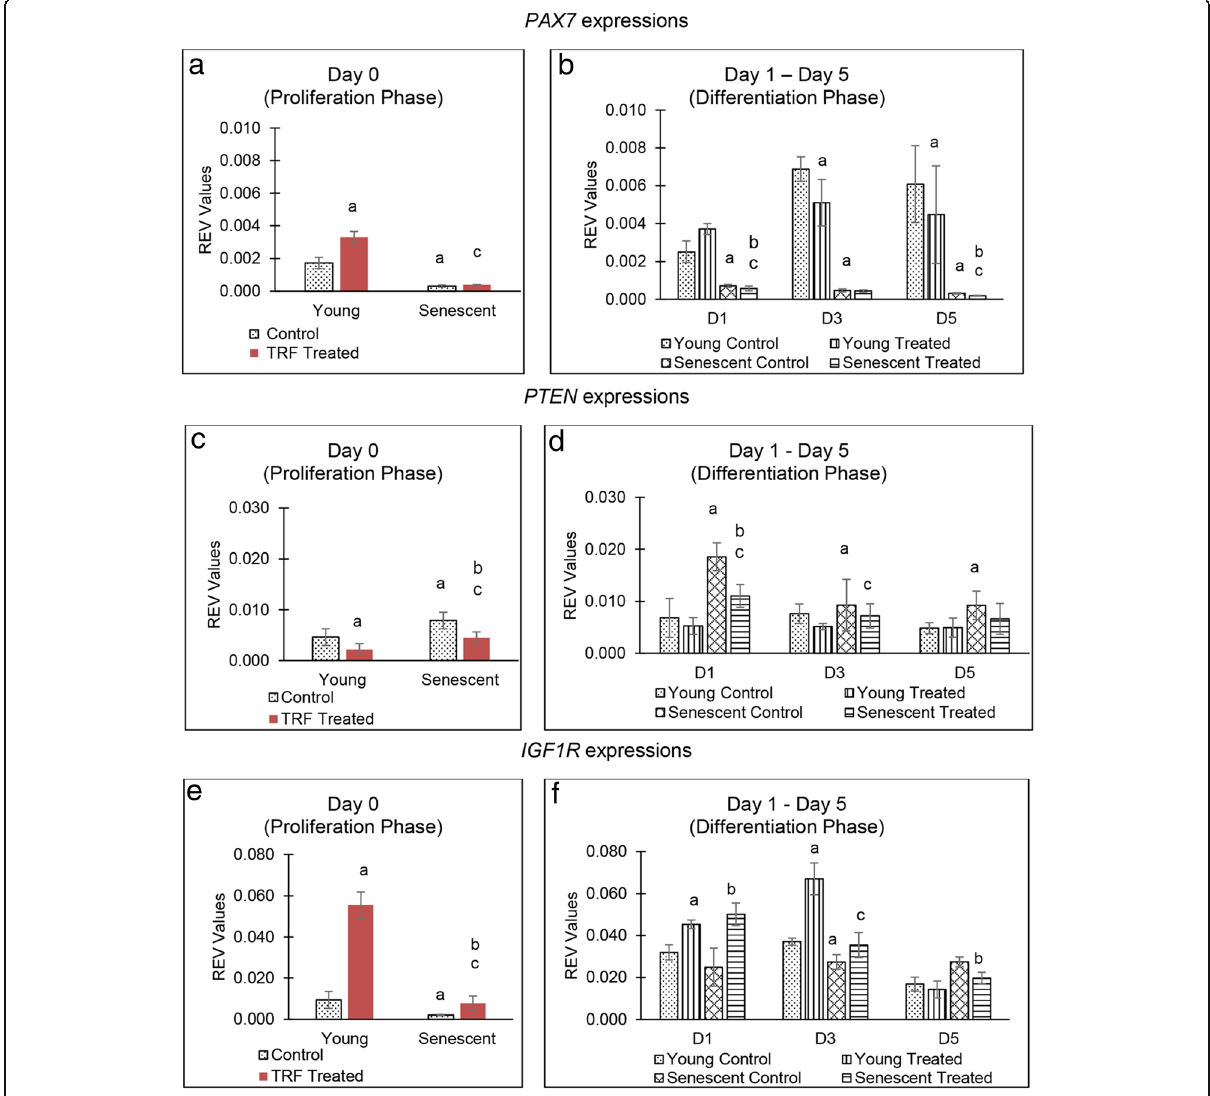
Fig. 5 Effect of TRF on the downstream genes expression. Expression of PAX7 ( a , b ), PTEN ( c , d ) and IGF1 R ( e , f ) in young control myoblasts, TRF- treated young myoblasts, senescent control myoblasts and TRF-treated senescent myoblasts. a Denotes p < 0.05 compared to young control, b p < 0.05 compared to senescent control and c p < 0.05 compared to young treated myoblasts. Data are presented as relative expression value